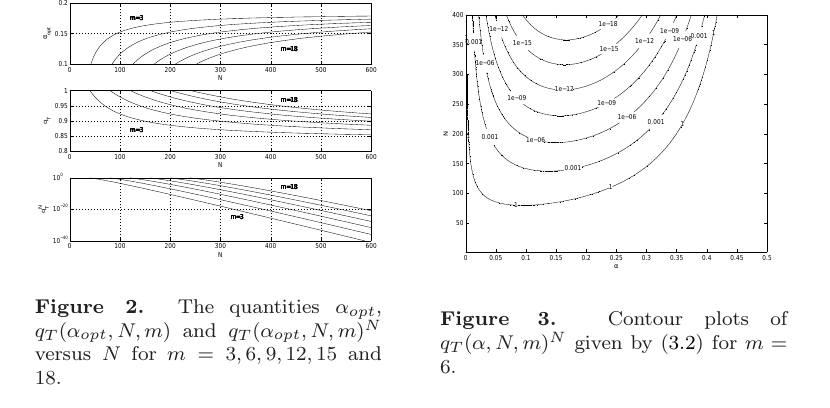
Figure 3. Contour plots of q T ( α,N,m ) N given by (3.2) for m = 6